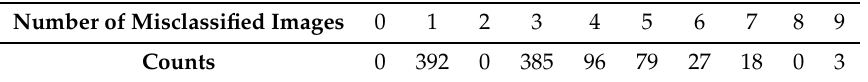
Table 10. Statistical study: number of misclassifications vs. counts, for 1000 counts in